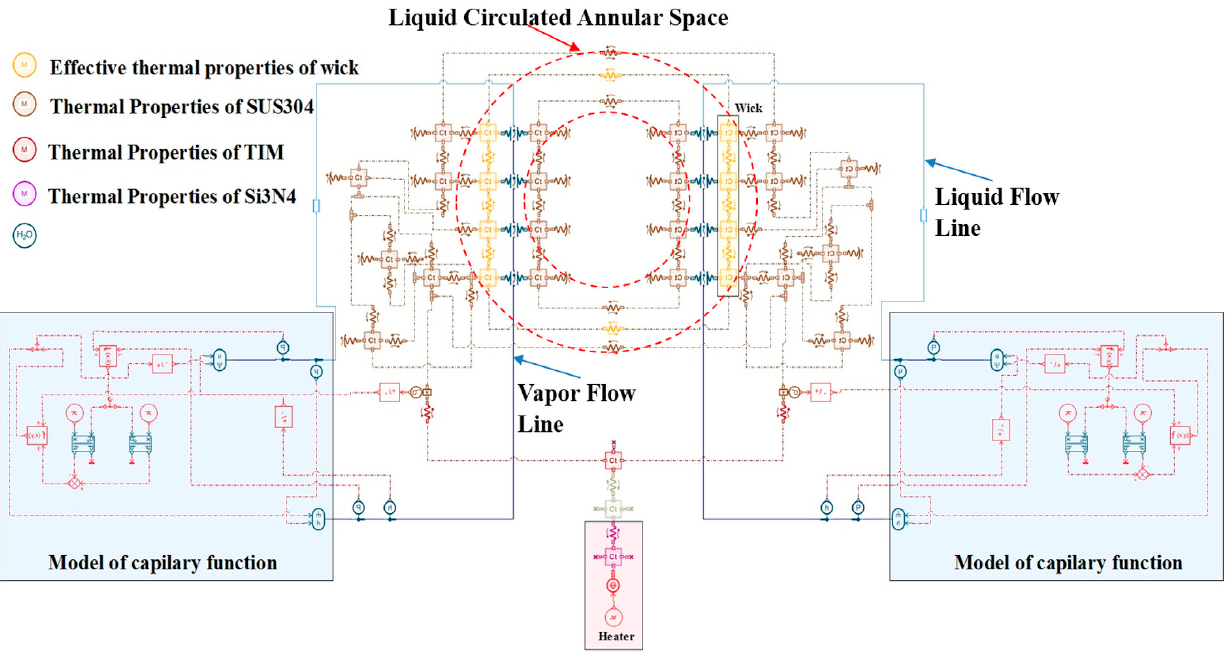
Figure 3. One-dimensional AMESIM modeling of the CAHP. Table 4. Main AMESIM library components used in the CAHP model.